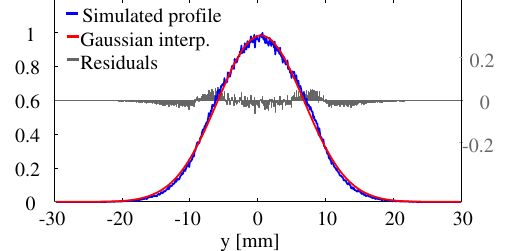
FIG. 22. The Gaussian shape is lost already after 1000 turns (1 ms).